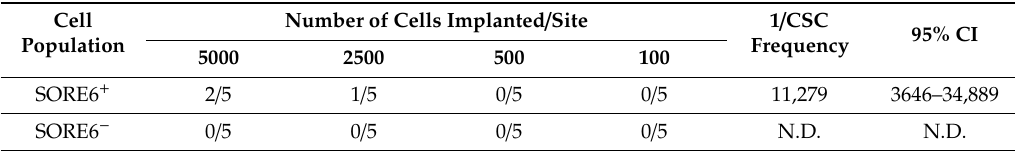
Table 1. The frequency of tumor formation in nude mice ( n = 5) inoculated with the indicated number of SORE6 + and SORE6 − cells sorted from PC3 cells. The tumor incidence was assessed via BLI, two months after inoculation. CI, conference interval. p , p value for the difference in CSC frequencies between the SORE6 + and SORE6 − cells. Table 2. The frequency of tumor formation in nude mice ( n = 5) inoculated with the indicated number of SORE6 + and SORE6 − cells sorted from DU145 cells. The tumor incidence was assessed via palpation, four months after inoculation. CI, conference interval. N.D., not detectable.